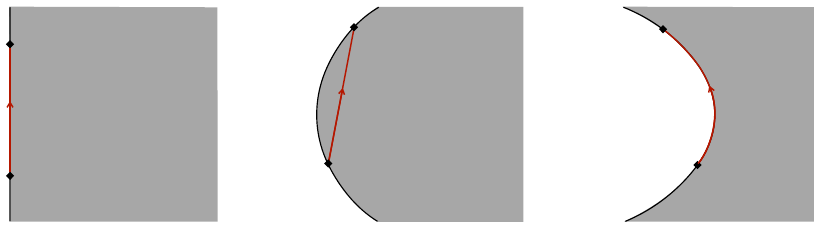
Figure 8 . Time slices of (2+1)D static Σ with different extrinsic curvatures on ∂ Σ . The left, middle, right figure show k ˜ m u ˜ n = 0 , k ˜ m u ˜ n < 0 and k ˜ m u ˜ n > 0 , respectively. Consider ˜ m ˜ n u ˜ m ˜ n u ˜ m ˜ n u sending a signal from ∂ Σ to another location on ∂ Σ . The shortest paths are shown by red arrows. When k ˜ m u ˜ n = 0 , the shortest path is a null geodesic on ∂ Σ which is also a null geodesic ˜ m ˜ n u in Σ . When k ˜ m u ˜ n < 0 , the shortest path is a null geodesic in the ambient Σ \ ∂ Σ . When ˜ m ˜ n u k ˜ m ˜ n u ˜ m u ˜ n > 0 , the shortest path is a null geodesic on ∂ Σ which is not a geodesic in Σ